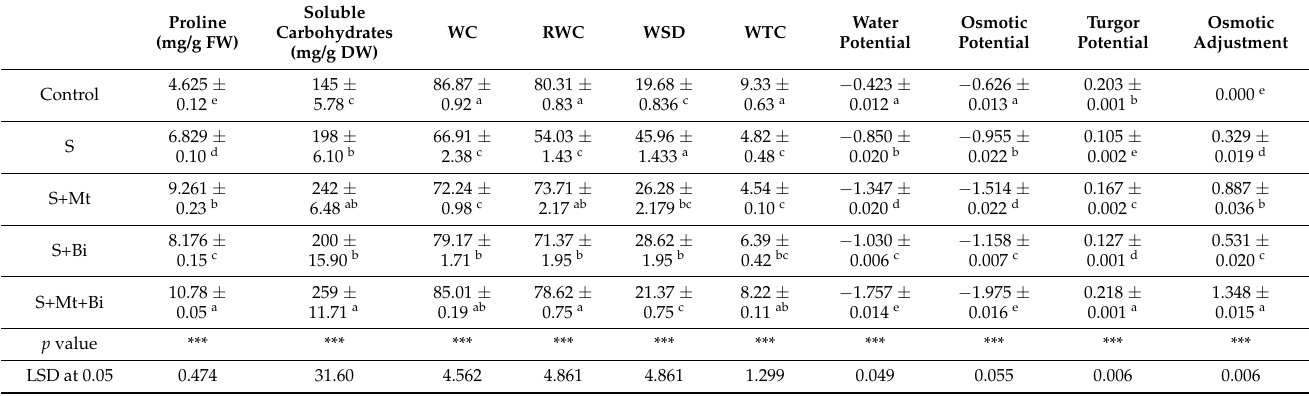
Table 1. The effect of melatonin (Mt) and/or biochar (Bi) supply on osmolyte accumulation, plant water relations, water potential (mega-pascal, Mpa), osmotic potential (Mpa), turgor potential (Mpa), and osmotic adjustment (Mpa) of borage plants grown in a saline medium (S, 5000 ppm